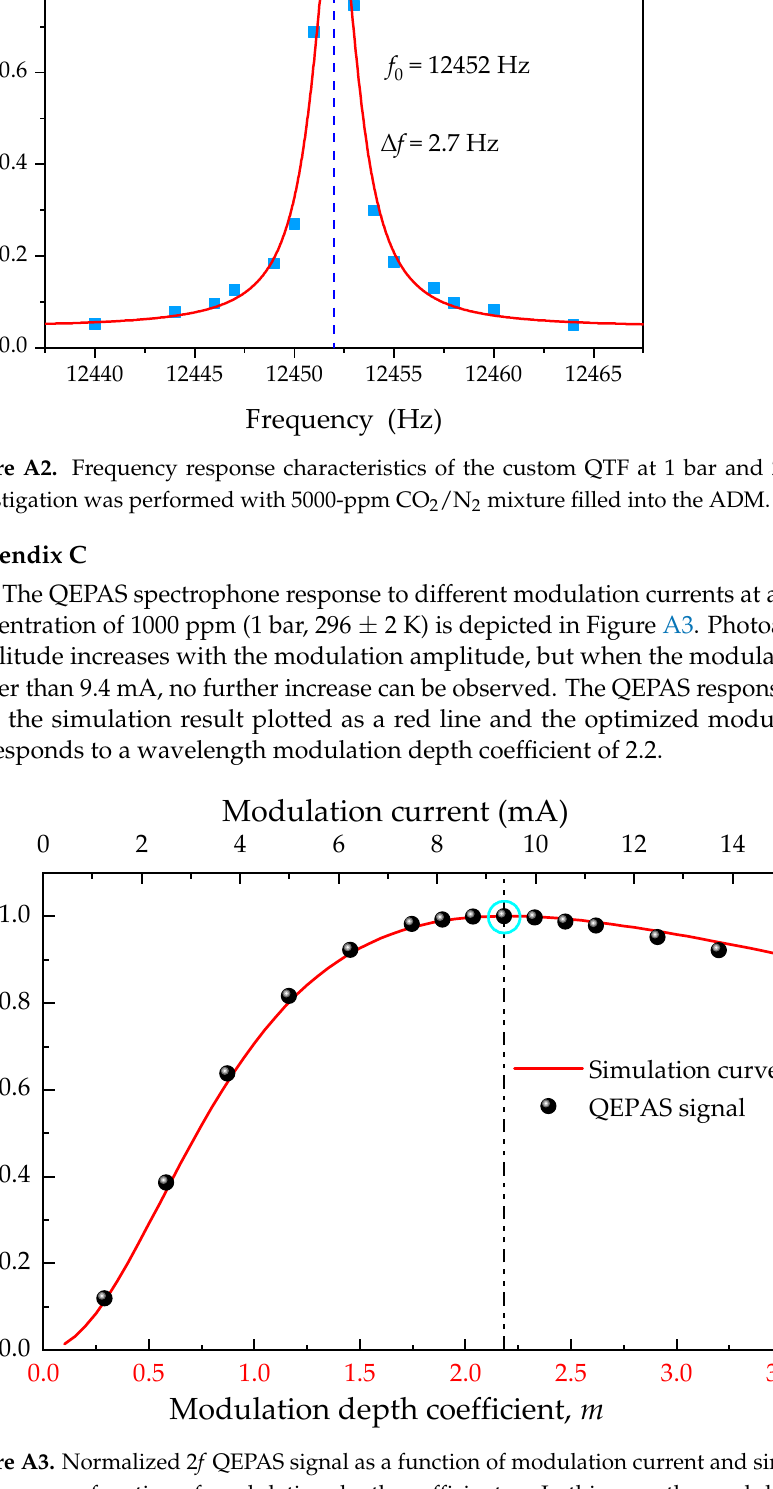
Figure A3. Normalized 2 f QEPAS signal as a function of modulation current and simulated QEPAS response as a function of modulation depth coefficient m . In this case, the modulation current of 9.4 mA corresponds to the maximum 2 f -QEPAS signal at m = 2.2.